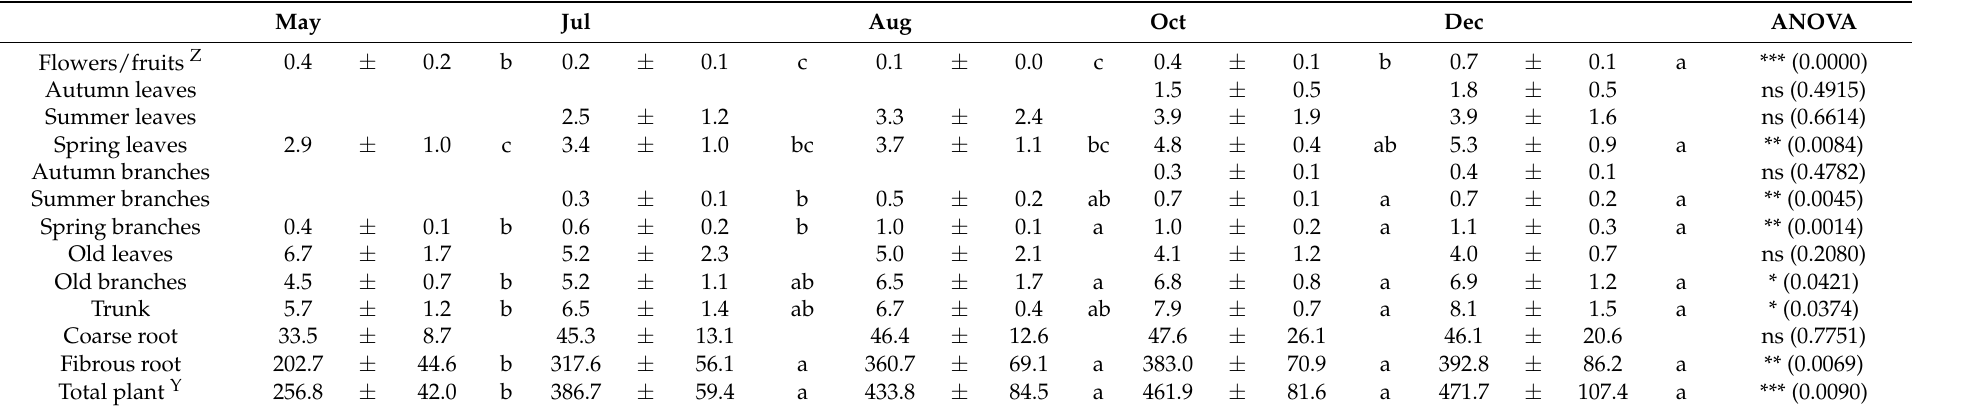
Table 3. Total Fe content (mg Fe) in the main organs and the plant of Nules clementine trees uprooted in May (flowering), July (fruit set and the end of fruit drop), August (fruit growth), October (fruit growth), and December (fruit maturity). Values are means ± SD (n = 4). Different lowercase letters indicate significant differences based on one-way analysis of variance. Significant effects of the Fe dose applied are given at p ≤ 0.05 (*), p ≤ 0.01 (**), p ≤ 0.001 (***), and ns (not significance) at each plant component. p -value between brackets (LSD